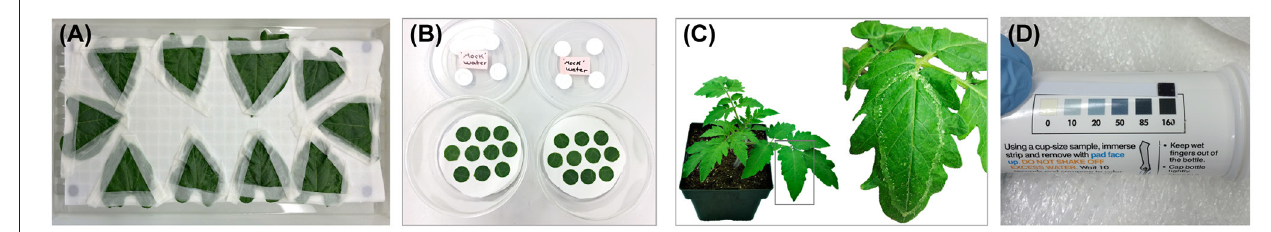
FIGURE 1 | Experimental set-ups. (A) The detached bean leaf experimental set-up. (B) The bean leaf disk experimental set-up. (C) The experimental set-up for priming experiment on tomato. (D) A PAA test-strip showing proper PAA activity.